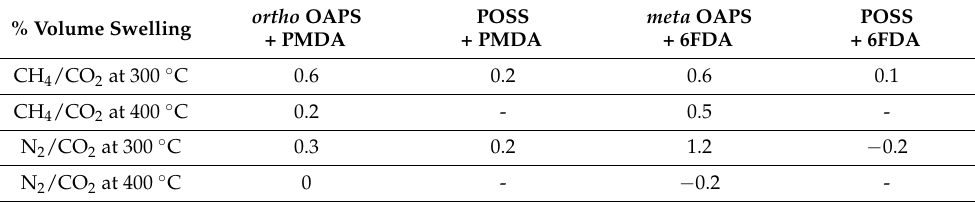
Table 7. Average percent of volume swelling upon sorption of 90%/10% CH 4 /CO 2 and N 2 /CO 2 mixtures at 60 bar in the four selected polyOAPS/POSS-imides at both 300 ◦ C and 400 ◦ C. The maximum standard error is 0.2%.